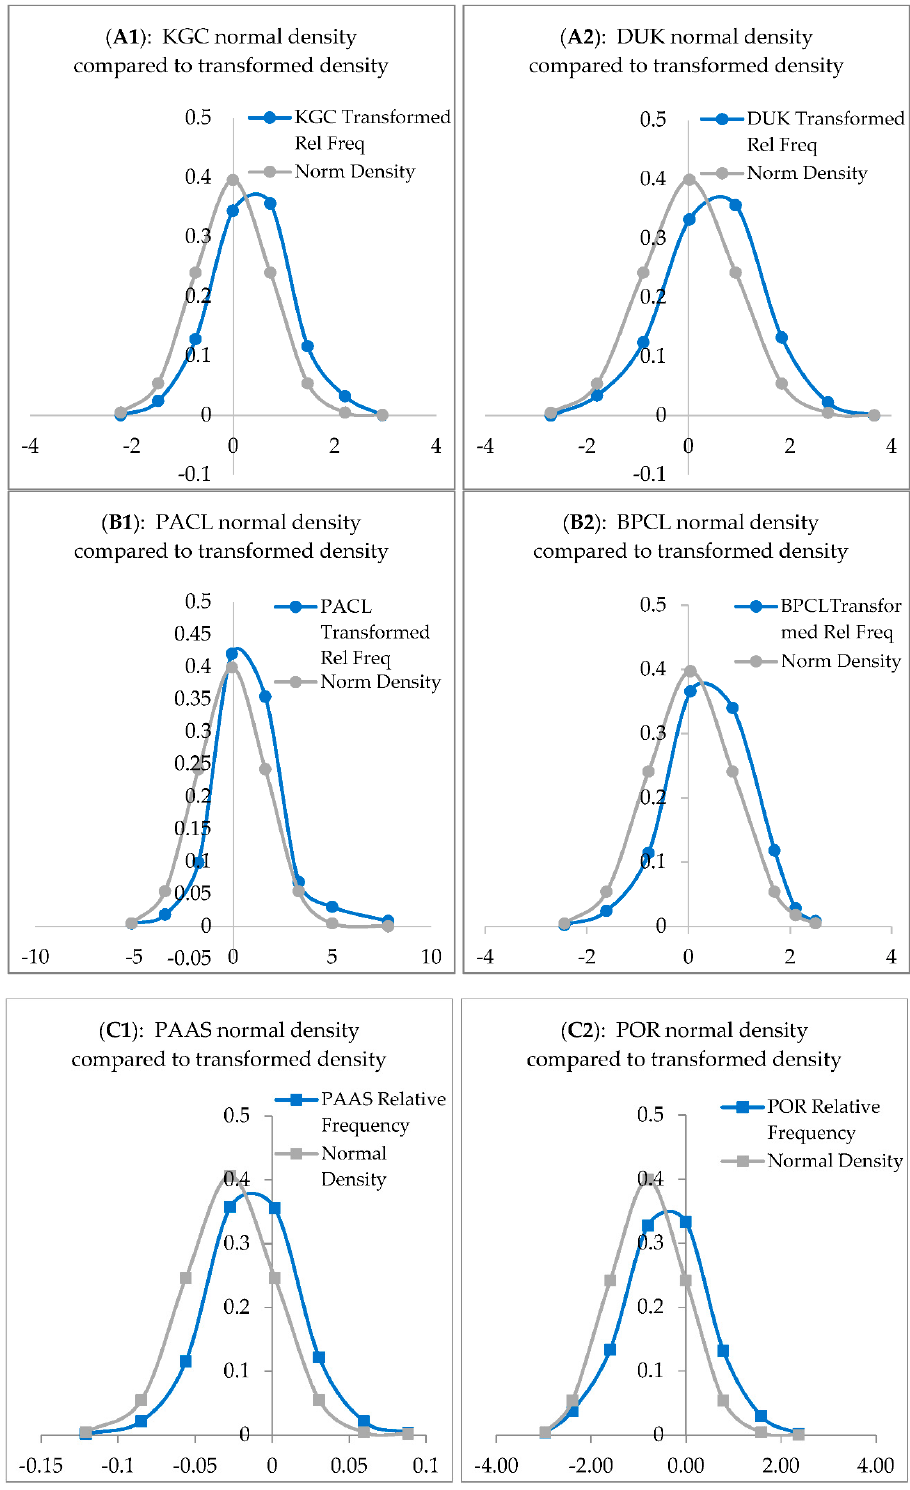
Figure 3. Returns distribution for the six stocks after